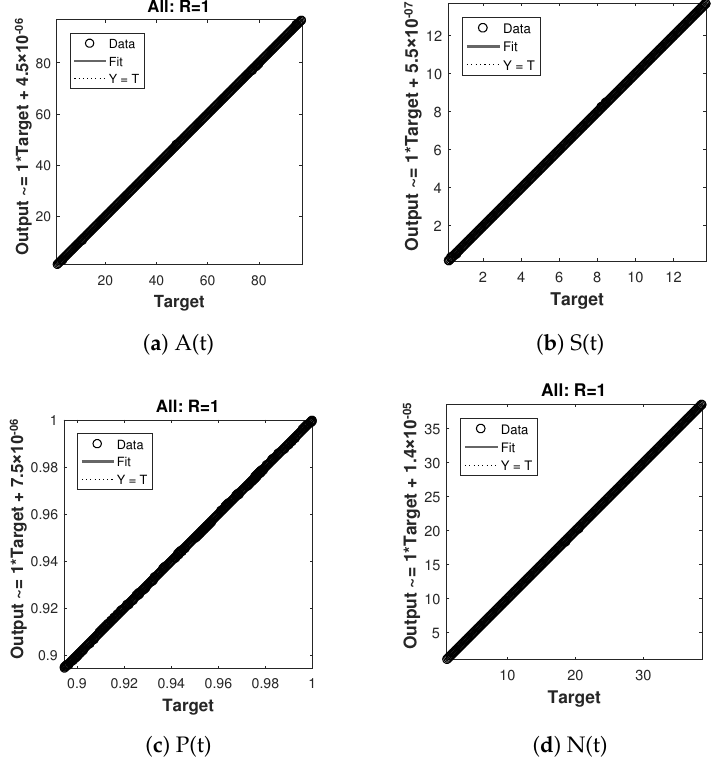
Figure 11. Regression analysis of nonlinear model of crop production for case